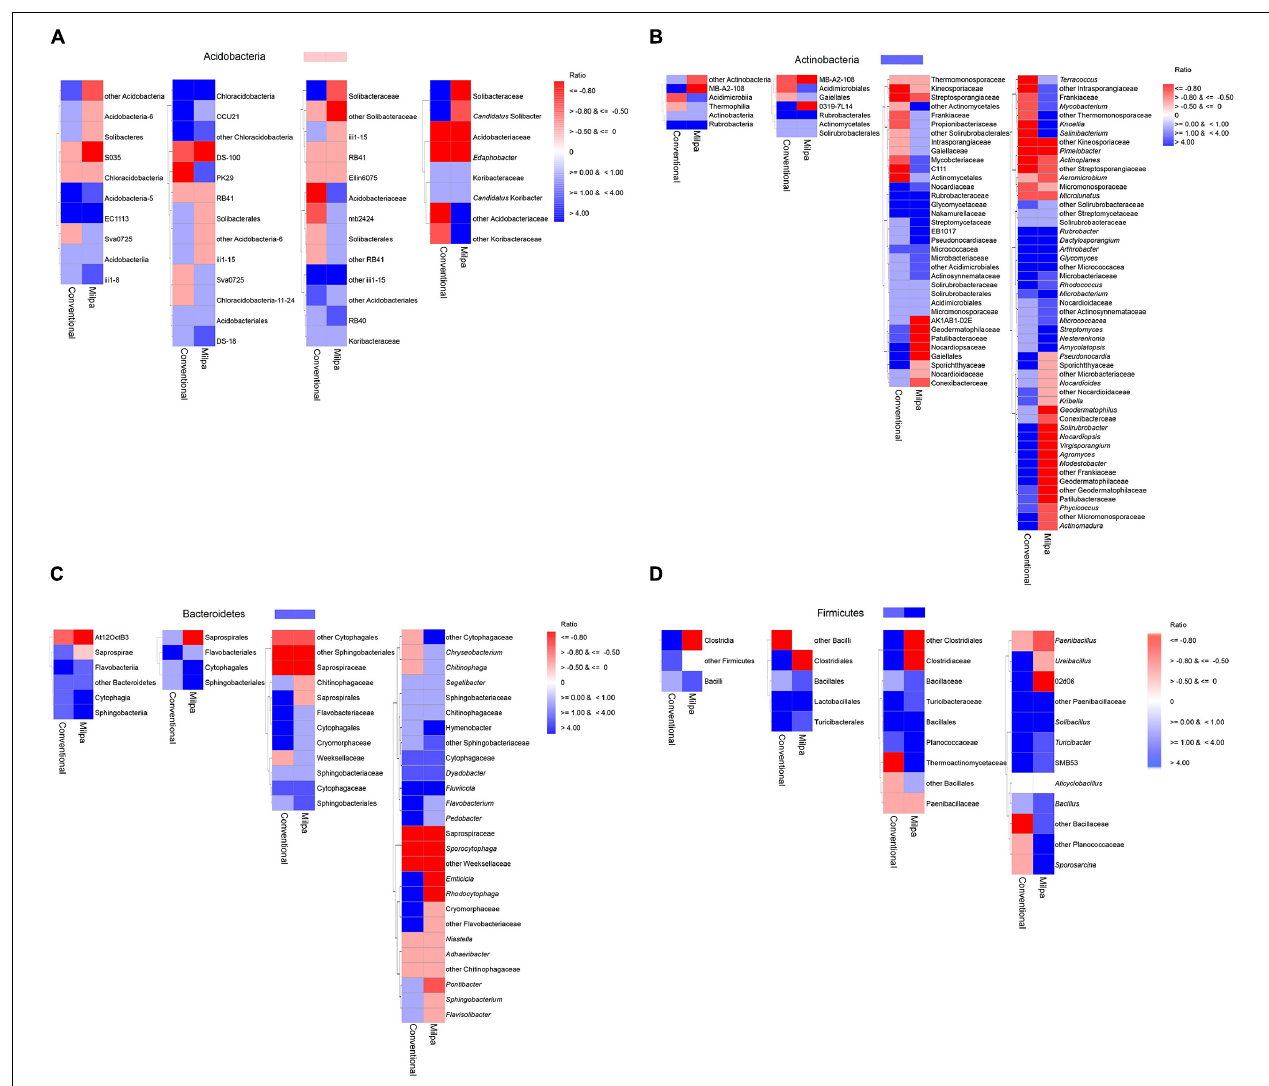
FIGURE 7 | Heat map of the effect of water content on the relative abundance of different bacterial taxonomic groups of the (A) Acidobacteria, (B) Actinobacteria, (C) Bacteroidetes, and (D) Firmicutes in the conventional or milpa cultivated soil [Ratio = (the relative abundance of the bacterial group in soil at 5% field capacity (FC) minus the relative abundance of the bacterial group in the soil incubated at FC)/the relative abundance of the bacterial group in the soil incubated at FC].